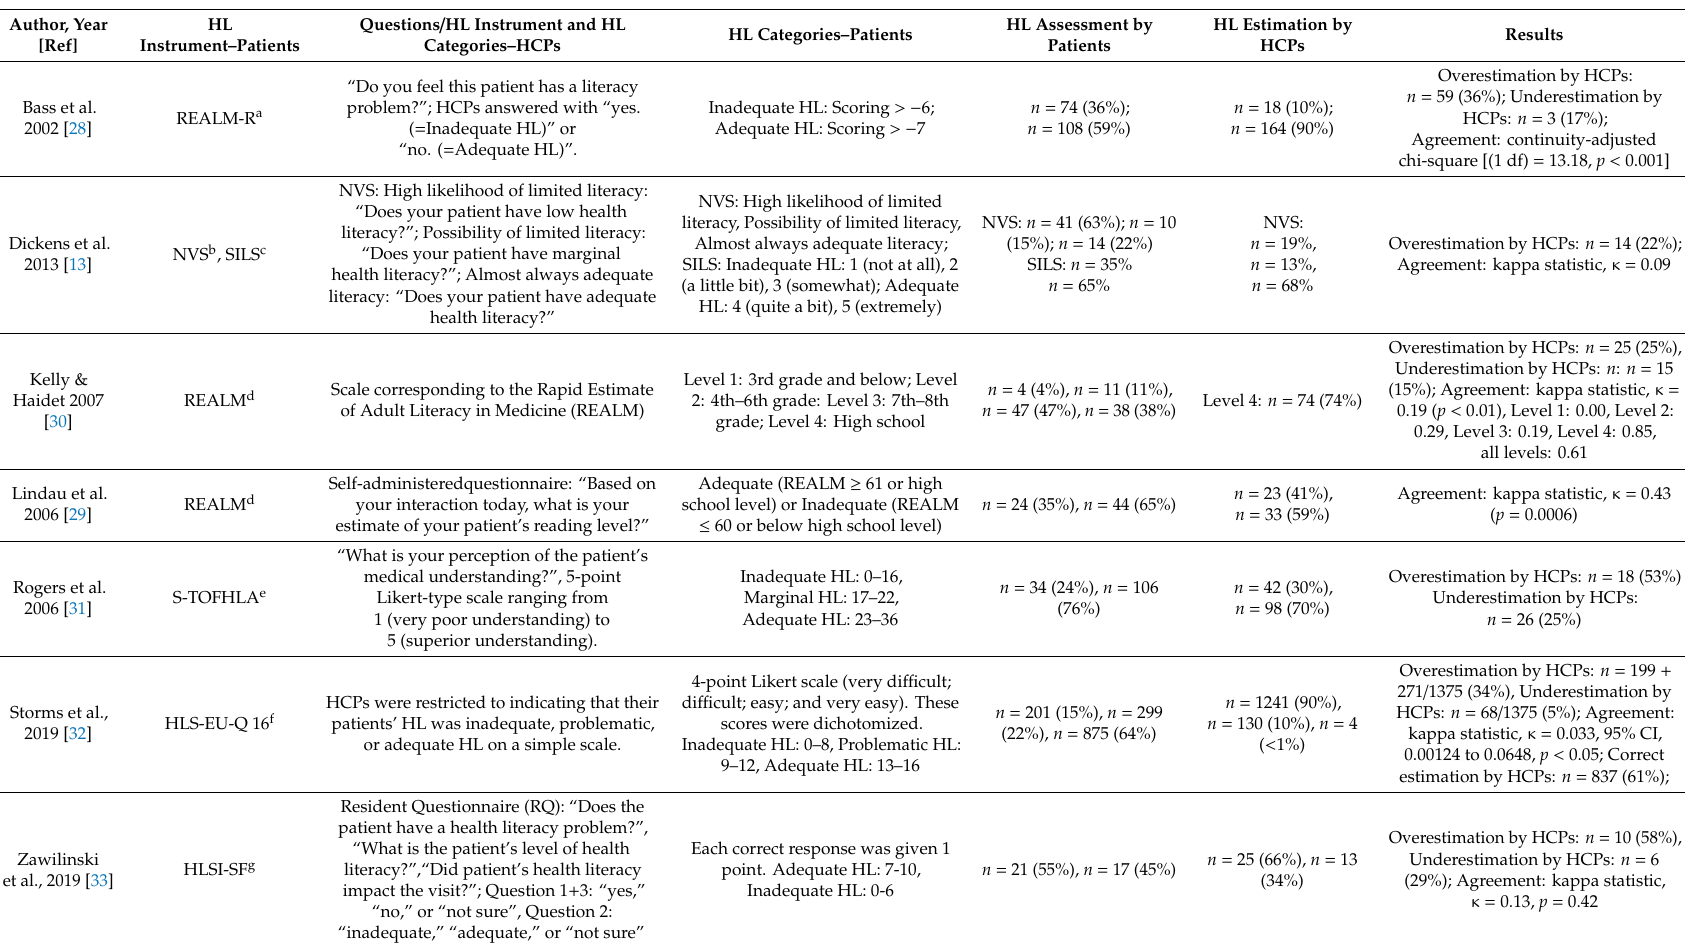
Table 3. Assessment and agreement of patients’ HL as evaluated by patients and